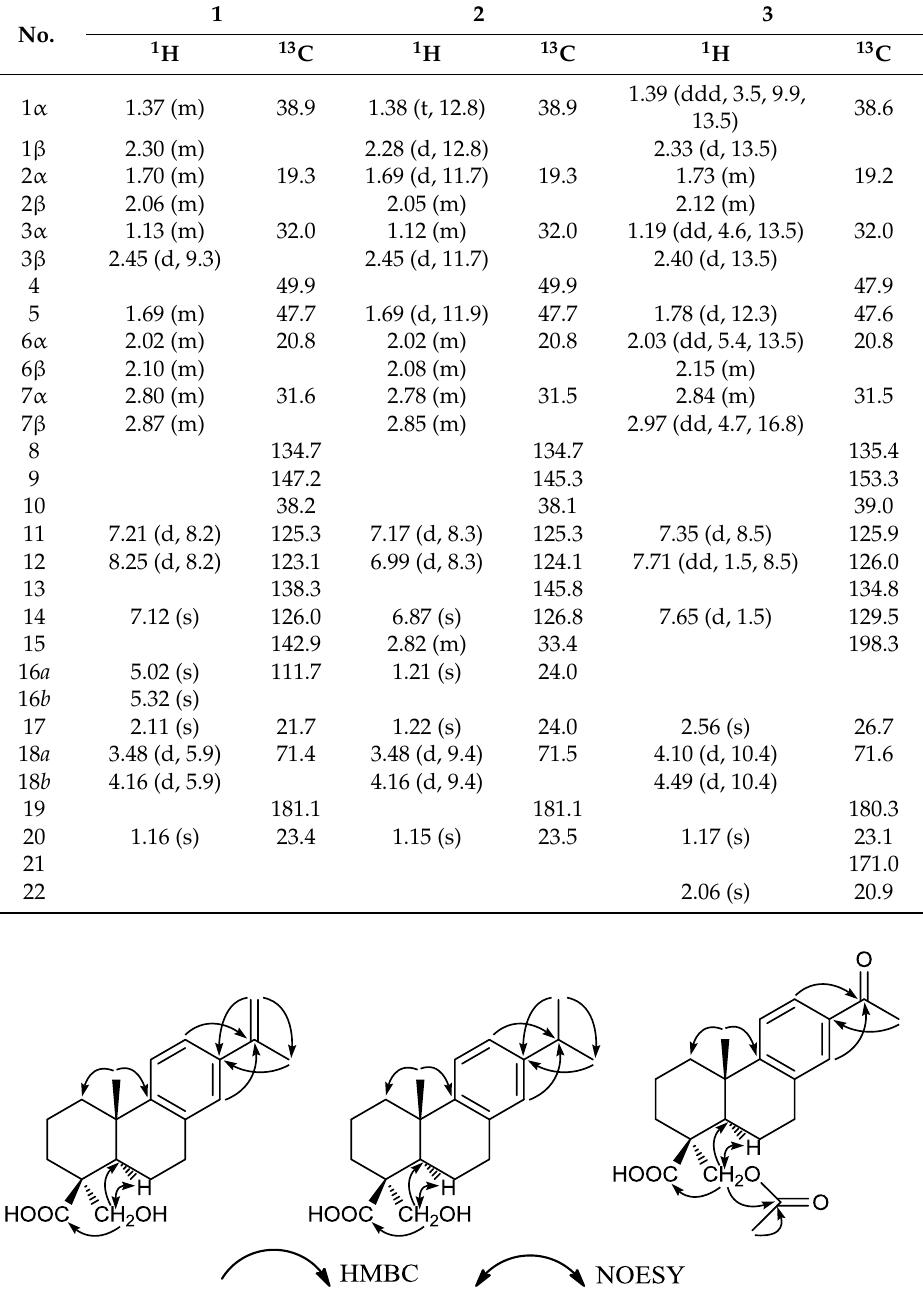
Figure 2. Key HMBC and NOESY correlations for compounds 1 to 3 .